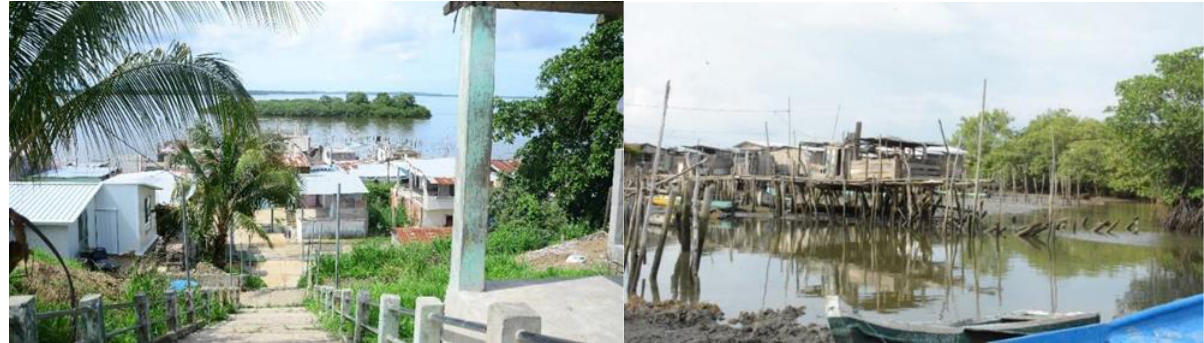
Figure 5. Landscapes of San Jos é de Chamanga © Shuwen Ye and Aubrey Jahelka. Figure 5. Landscapes of San Jos é de Chamanga © Shuwen Ye and Aubrey